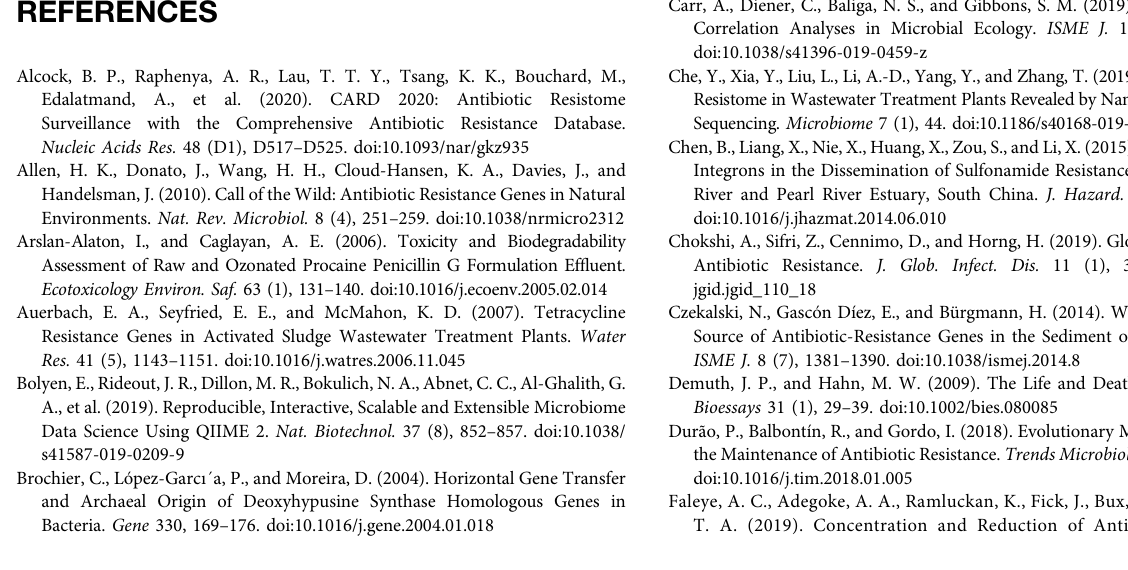
SUPPLEMENTARY FIGURE S1 | Microbial community composition of stream water samples at OTU level. (A) PCoA of stream water samples based on Bray- Curtis Index. (B) Pattern Search analysis of stream water